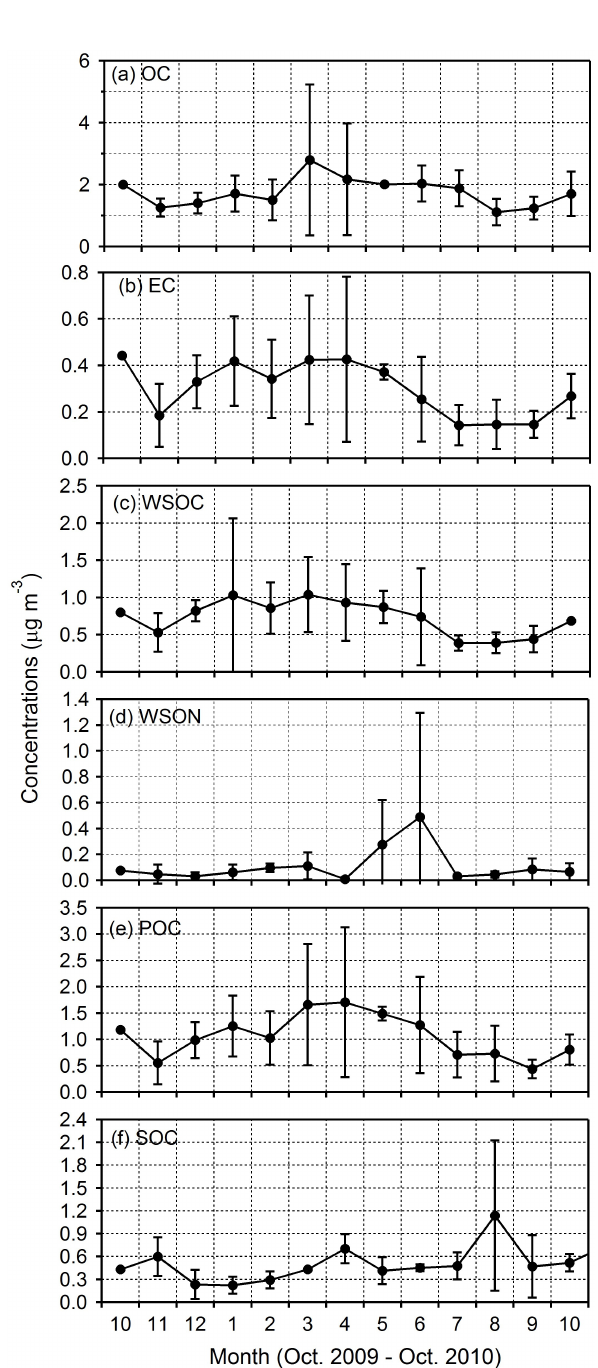
Fig. 4. Seasonal variation in concentrations of (a) organic carbon (OC), (b) elemental carbon (EC), (c) water soluble organic carbon (WSOC), (d) water soluble organic nitrogen (WSON), (e) primary organic carbon (POC), and (f) secondary organic carbon (SOC) in ambient aerosols collected in Cape Hedo,